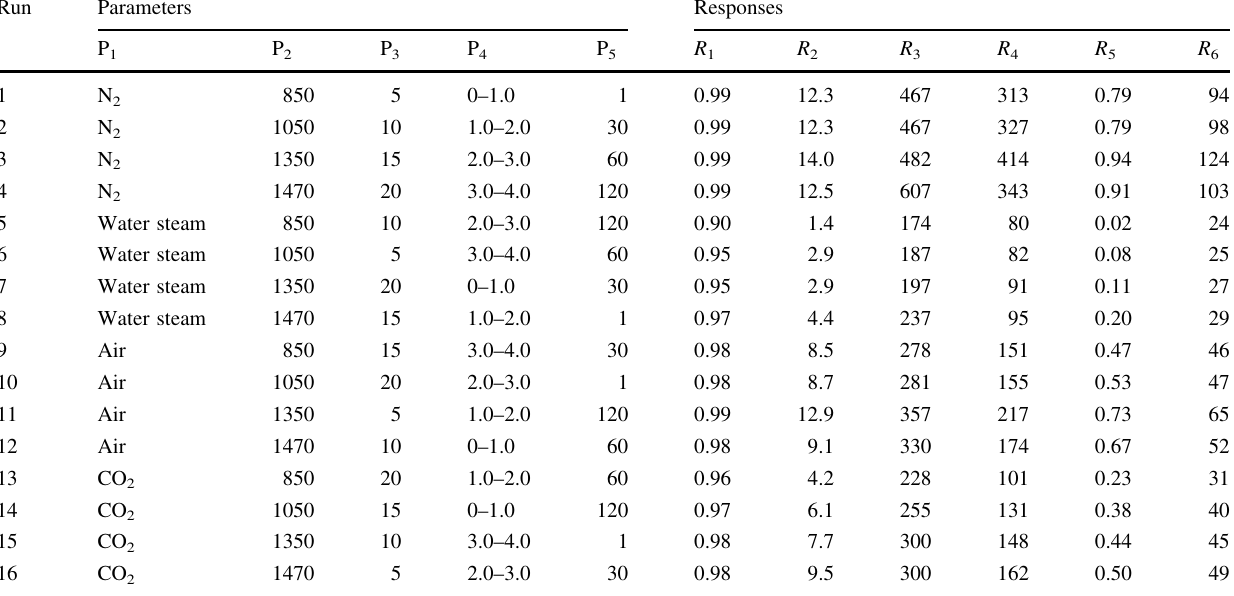
Table 3 The run test